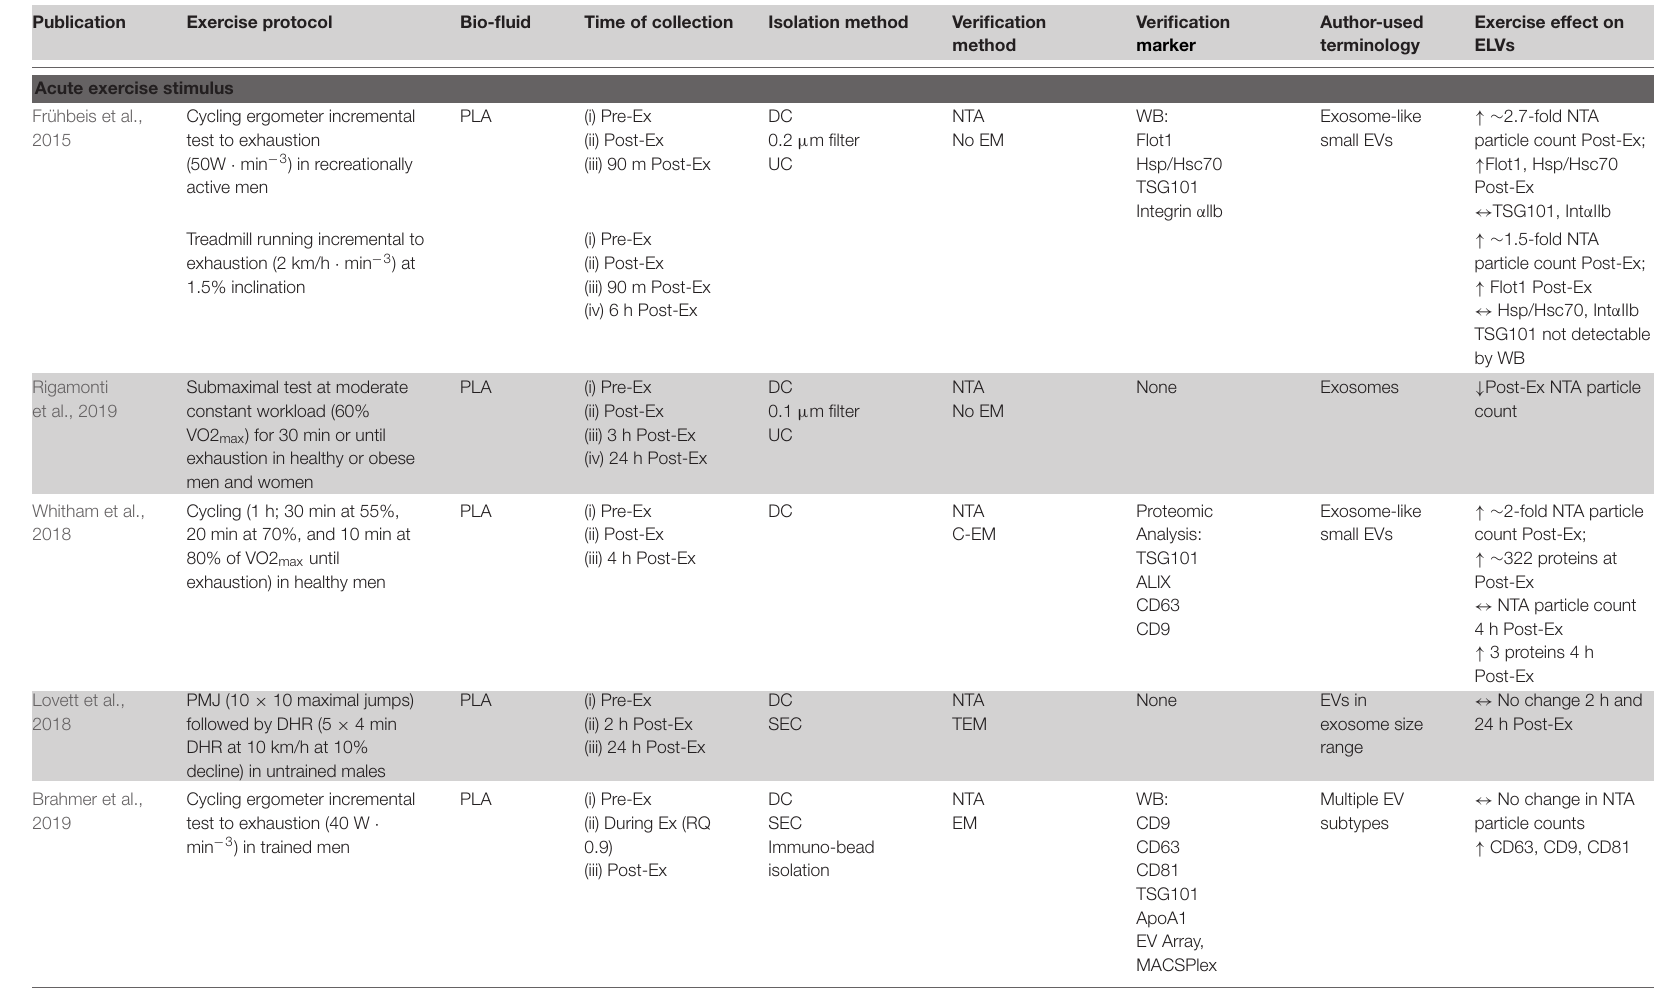
TABLE 1 | Effect of acute exercise on circulating exosome-like vesicles